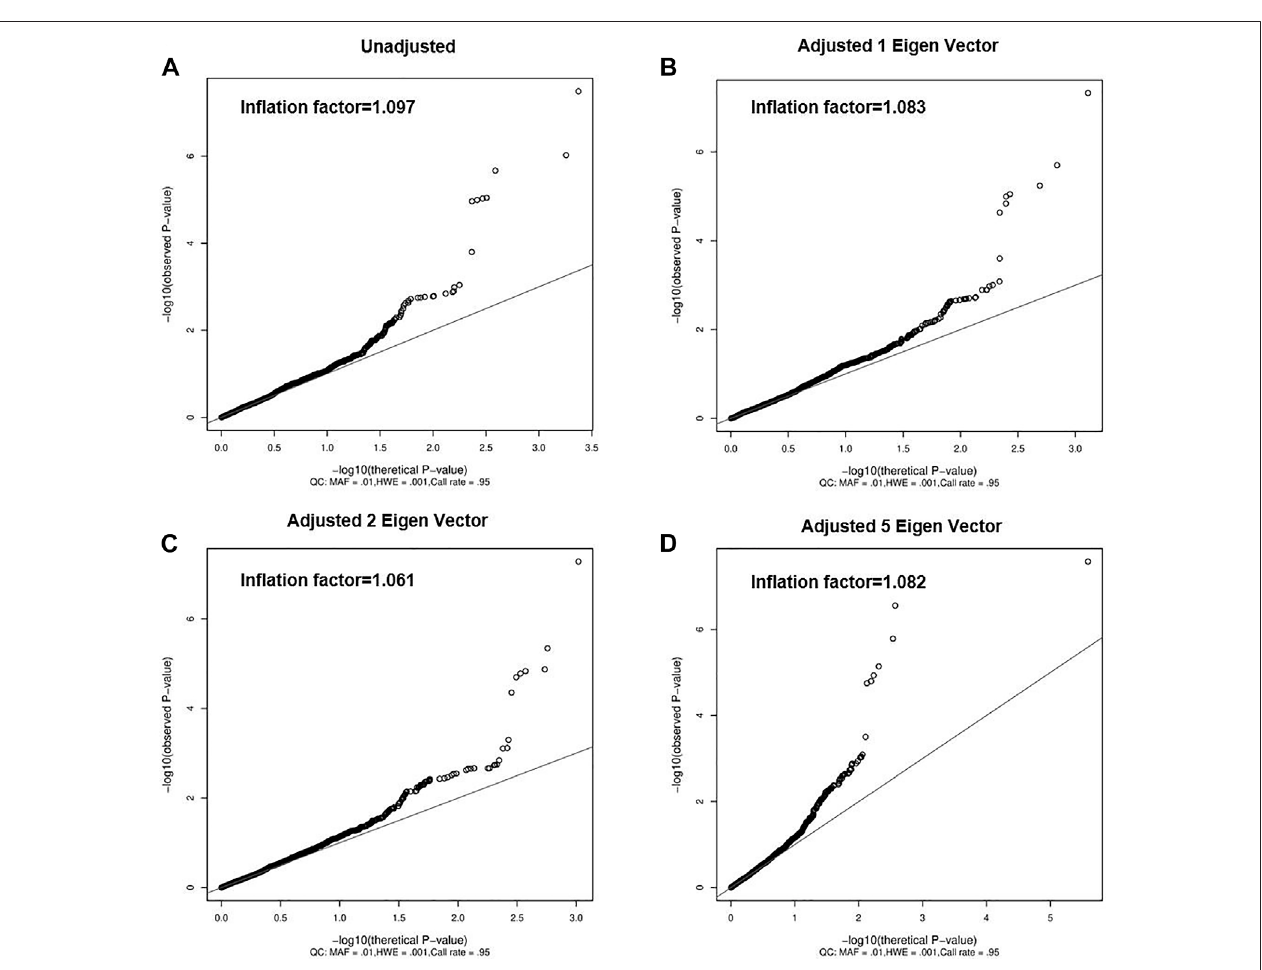
FIGURE 2 | Quantile-Quantile Plot of gallstones. (A) does not correct the eigen vector, (B) correct for the fi rst eigen vector, (C) correct for the top 2 eigen vectors and (D) correct for the top 5 eigen vectors. Solid lines indicate the null-hypothesis.